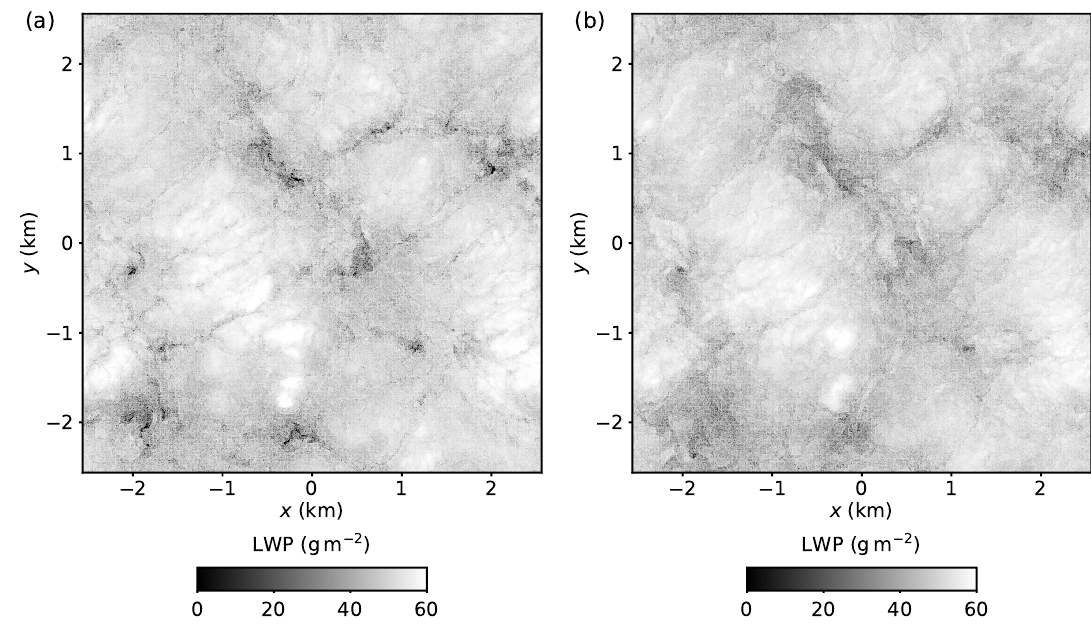
Figure 8. Liquid water path of the top-half of the cloud: ( a ) Case A1, and ( b ) Case M1.